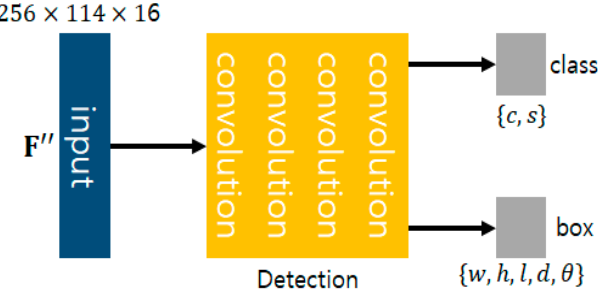
Figure 7. Configuration of a detection network.